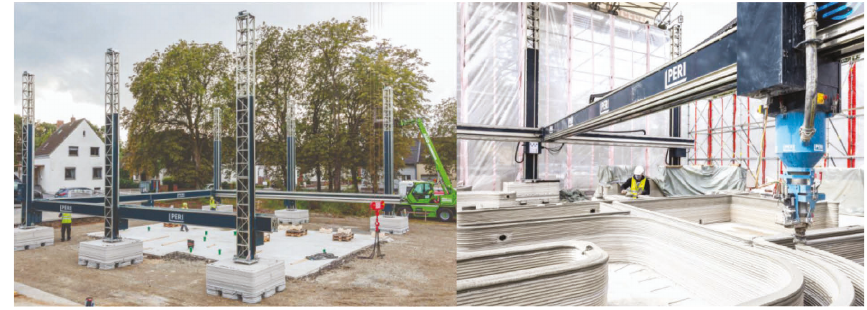
Figure 33: 3D printing house [66].